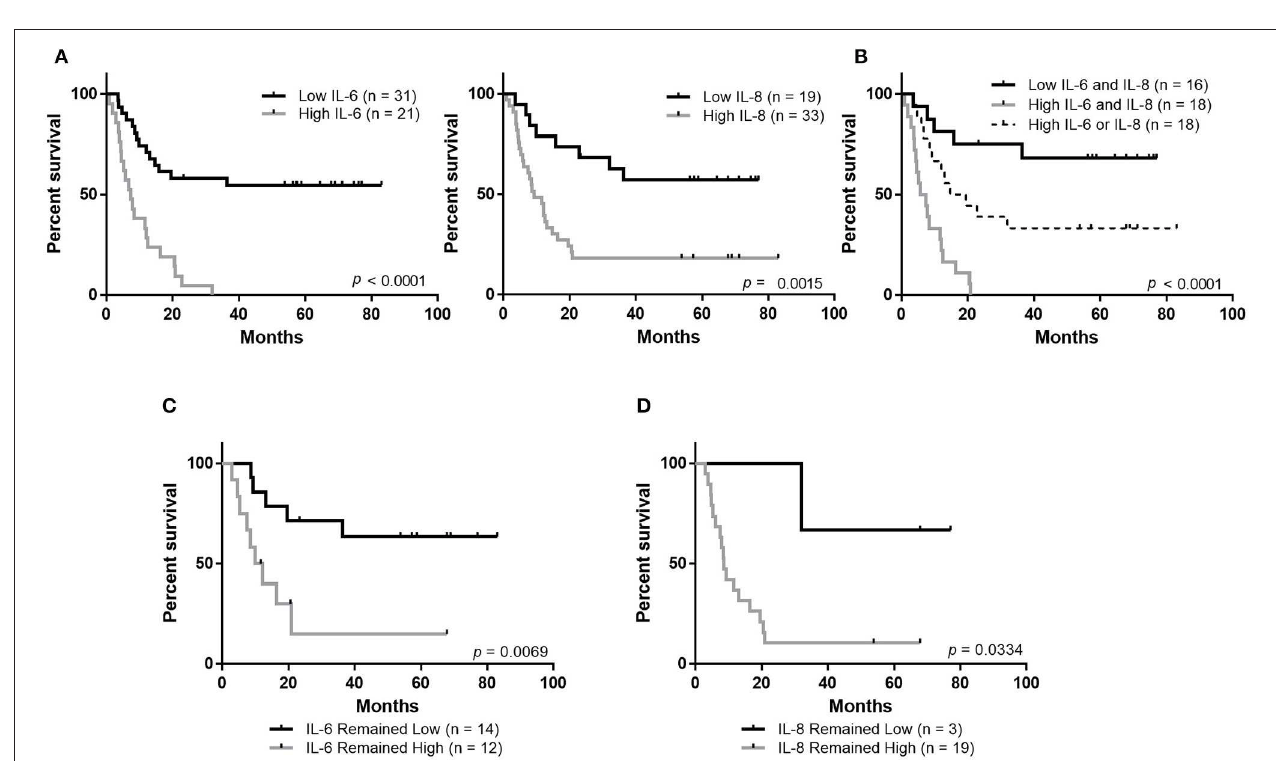
FIGURE 2 | Maintaining low circulating concentrations of IL-6 and IL-8 is associated with improved overall survival. (A) Overall survival of stage IV melanoma patients based on the plasma concentration of IL-6 or IL-8. (B) Overall survival based on the plasma concentration of IL-6 and IL-8. Analysis of overall survival of patients whose levels of IL-6 (C) or IL-8 (D) remained low or remained high during the follow-up